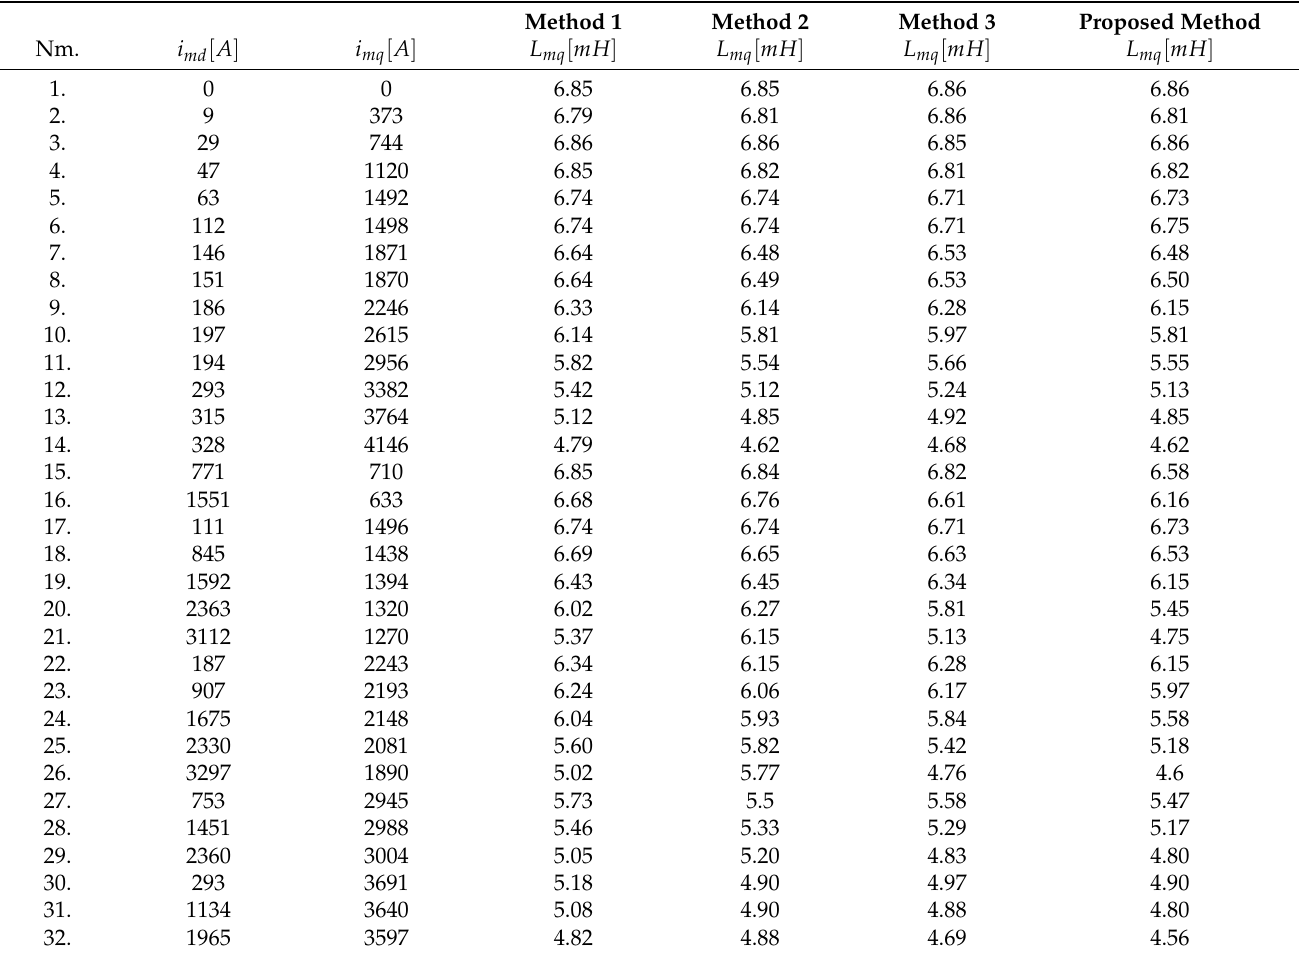
Table A2. Comparison of the obtained L mq